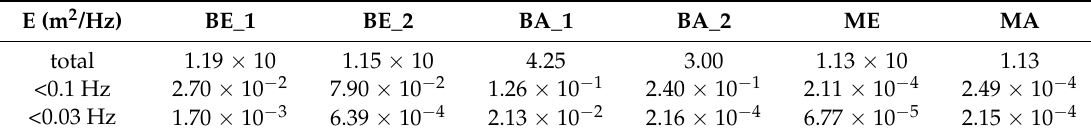
Table 6. Power spectral density for various sections of the spectra for the bichromatic and monochromatic tests.